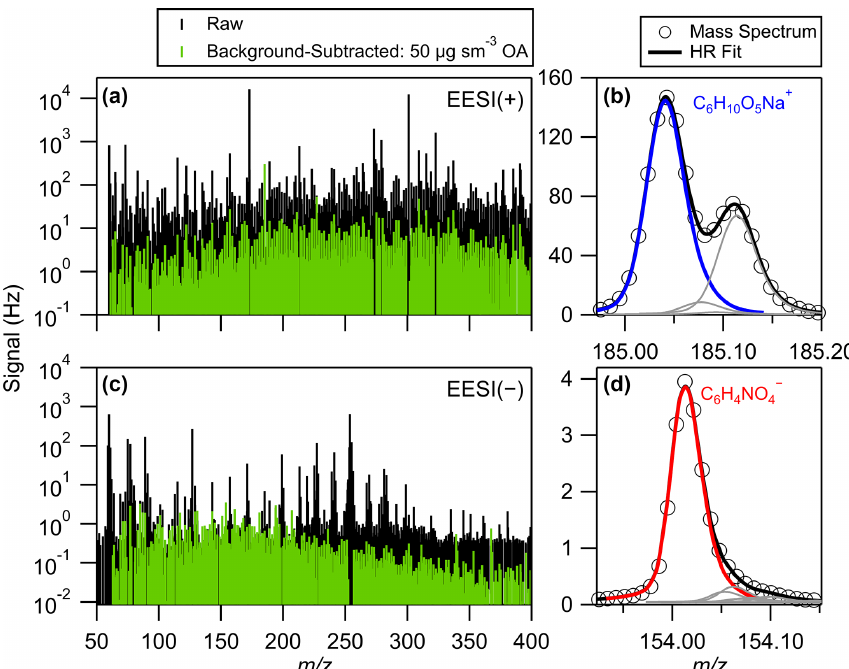
Figure 4. Raw and background-subtracted (a) EESI( + ) and (c) EESI( − ) spectra while sampling 50µgsm − 3 of wildland fire smoke aerosol and high-resolution mass spectra and peak fits of ions attributed to (b) levoglucosan and (d) nitrocatechol. The peaks shown in (b) and (d) are from the raw spectra in (a) and (c)